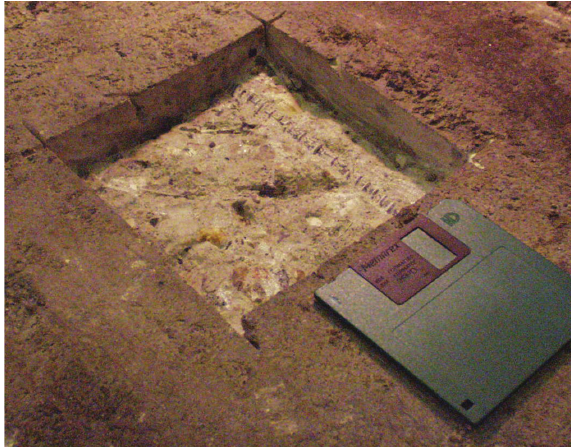
Figure 3: Photograph of damage induced on the